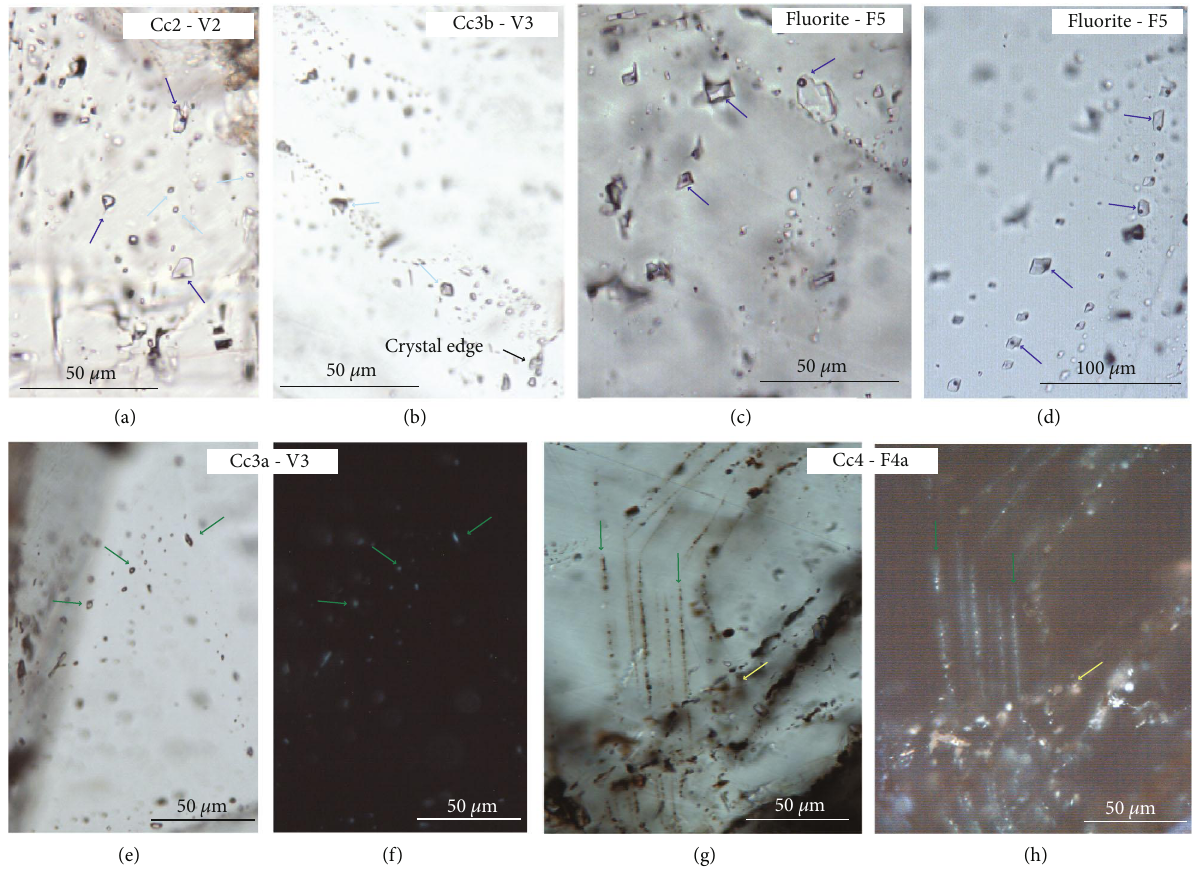
Figure 10: Photomicrographs of typical fl uid inclusions. (a) Example of stretched inclusions: dark blue arrows highlight primary two-phase aqueous inclusions with inconsistent L : V ratios and light blue arrows highlight primary single-phase aqueous inclusions. (b) Light blue arrows highlight pseudosecondary single-phase aqueous inclusions trapped along a plane that terminates at crystal edges. (c) Dark blue arrows highlight clustered primary two-phase aqueous inclusions with homogenous L : V ratios. (d) Dark blue arrows highlight primary aqueous two-phase inclusions with homogenous L : V ratios trapped along a growth zone. (e) Dark green arrows highlight primary three- phase oil ( L : V : S ) inclusions trapped along a growth zone. The solid phase is a hydrocarbon solid. (f) Blue fl uorescence of oil inclusions in (e) under UV light. (g) Dark green arrows highlight primary single-phase oil inclusions trapped along growth zones. The light green arrow highlights a trail of secondary two-phase oil inclusions. (h) Blue (dark green arrows) and dull orange (light green arrow) fl uorescence of oil inclusions in (g) under UV